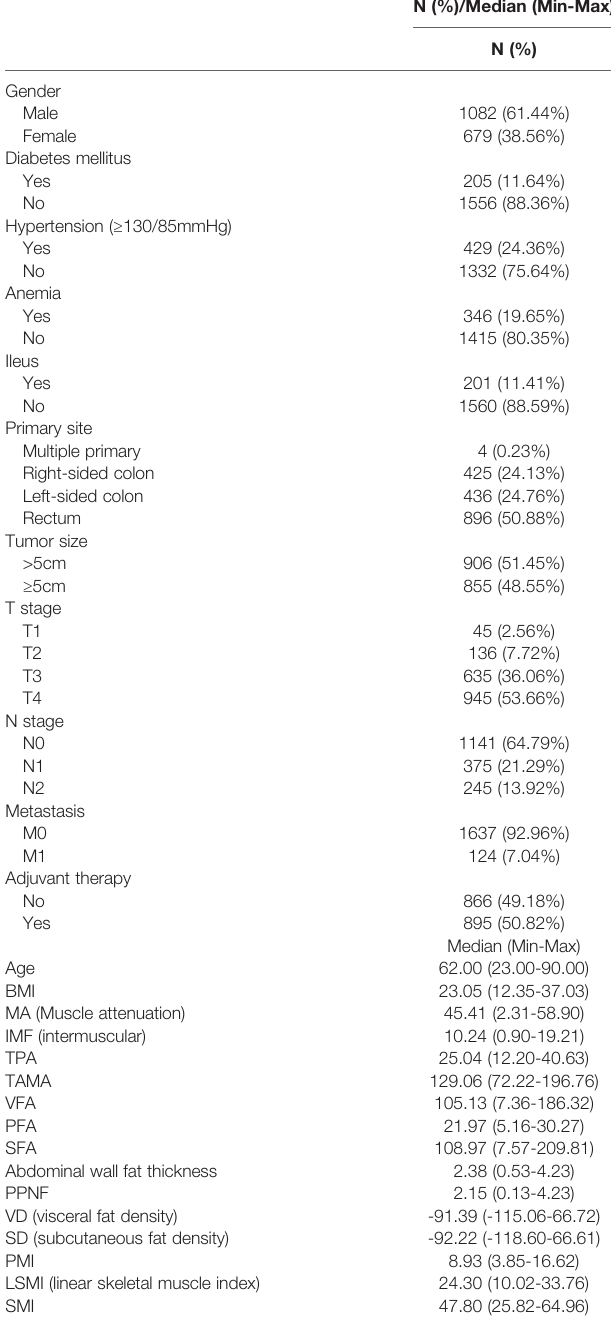
TABLE 1 | Baseline characteristics of study